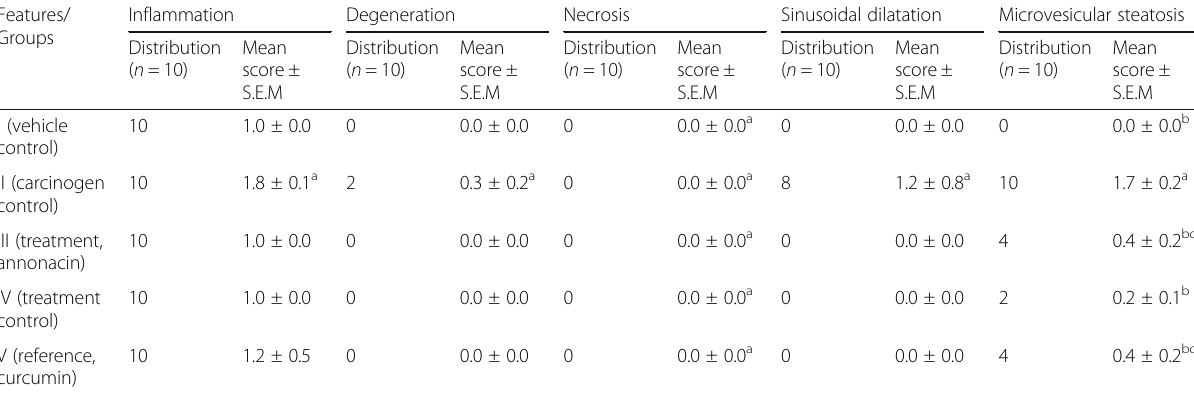
Table 2 The distribution and mean scores of histopathological changes due to toxicity in mice liver of each group Features/ Groups